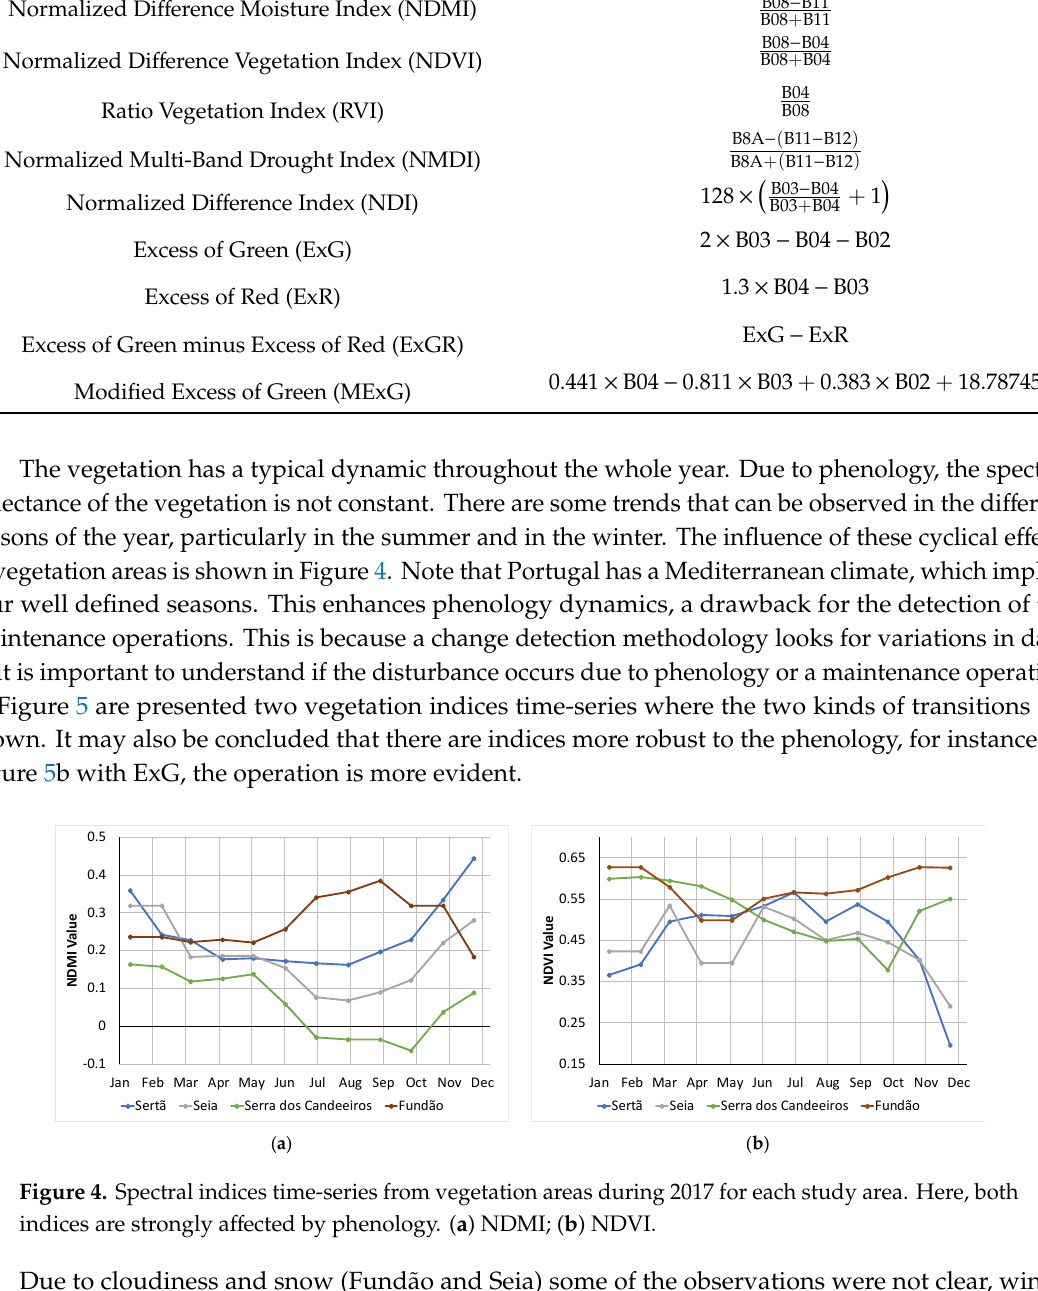
Table 1. Spectral indices equations.